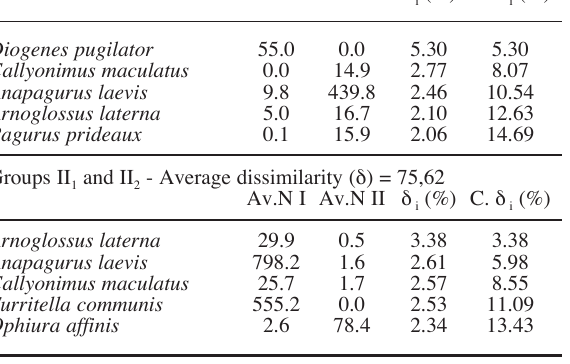
in the group (ind. 1000 m -2 ); δ explained; C. δ